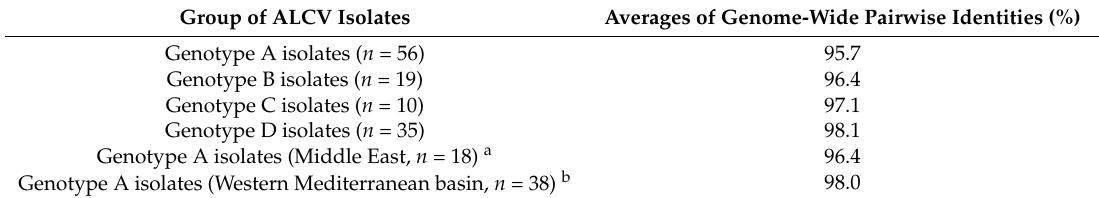
Table 1. Averages of alfalfa leaf curl virus genome-wide pairwise